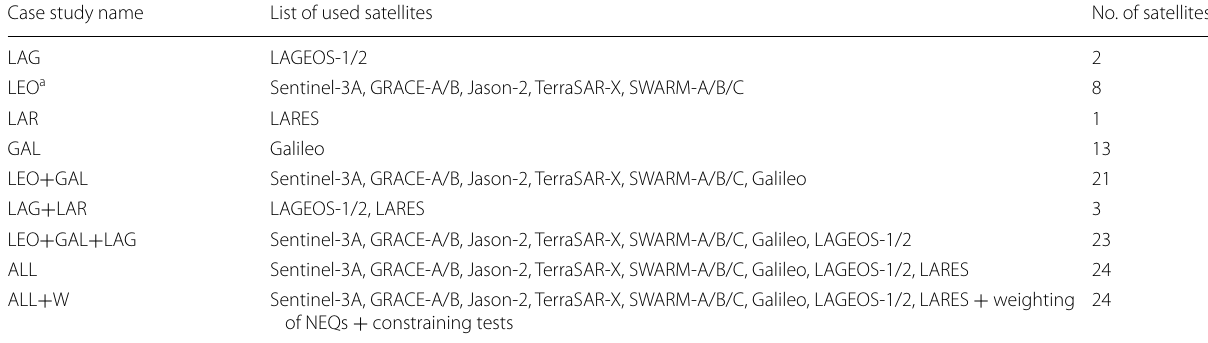
a Solutions for particular LEOs were derived